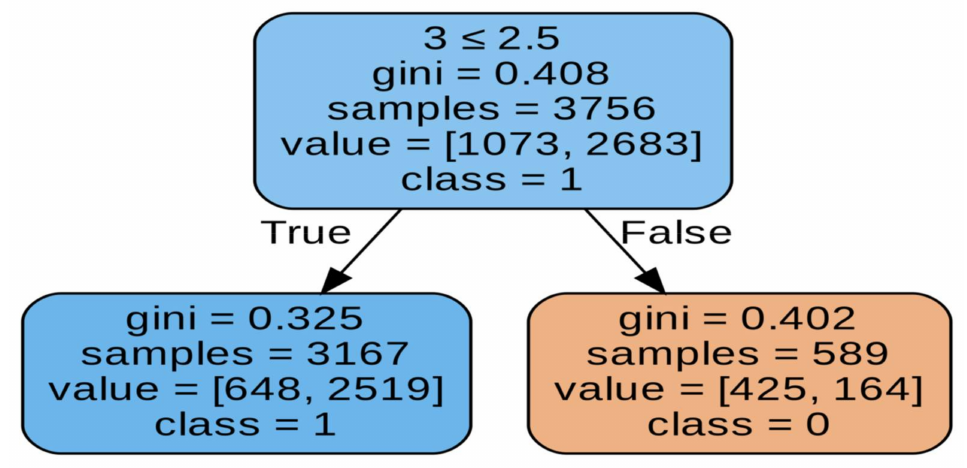
Figure 8. Visualization of the decision tree.